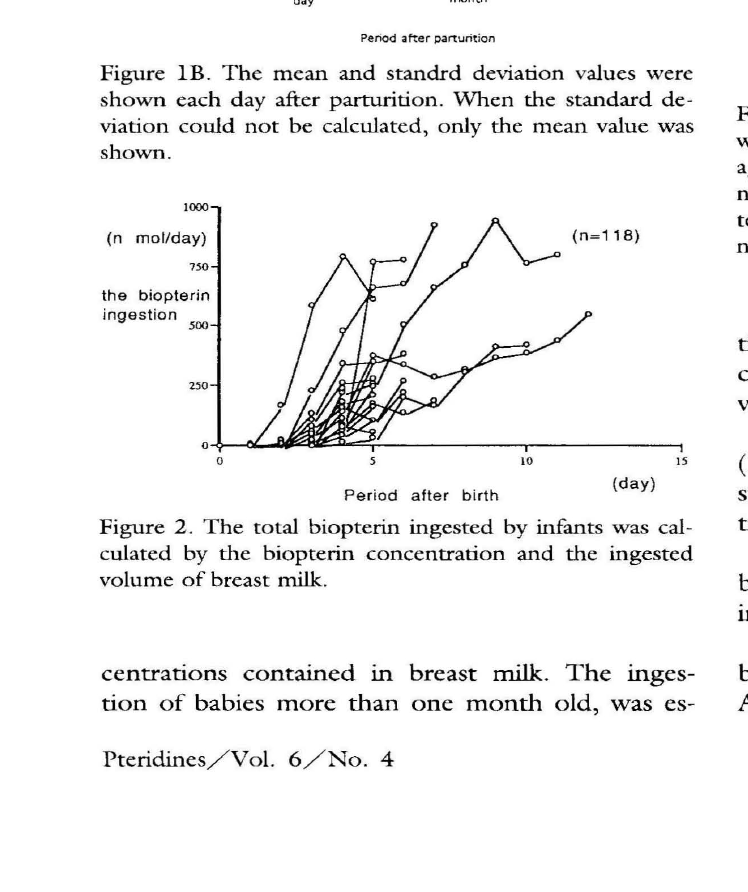
Figure 2 . The total biopterin ingested by infants was cal culated by the biopterin concentration and the ingested volume of breast milk.